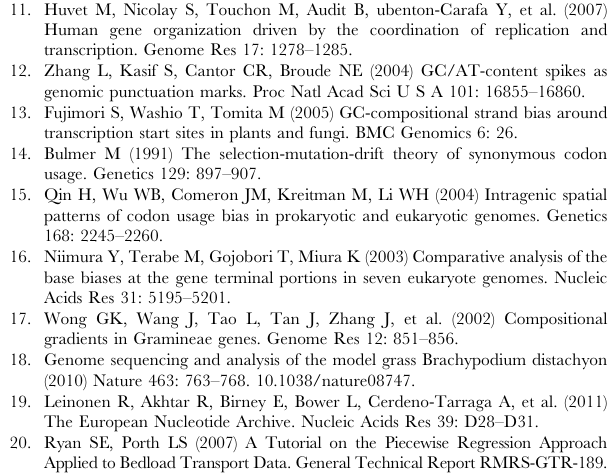
dataset with an adjacent window of 33 bp. The sequences were partitioned based on their length in seven dataset. Figure S19 Overall mononucleotide compositional trends of Physcomitrella coding sequences as a function of position and averaged over all sequences of each dataset with an adjacent window of 33 bp. The dataset ‘‘low’’ included sequence with a G + C content , = 0.40. The dataset medium included sequences with a G + C content . 0.40 and , = 0.50. Sequence with a G + C . 0.5 were included in the dataset ‘‘high’’. Figure S20 Overall mononucleotide compositional trends of Selaginella coding sequences as a function of position and averaged over all sequences of each dataset with an adjacent window of 33 bp. The dataset ‘‘low’’ included sequence with a G + C content , = 0.40. The dataset medium included sequences with a G + C content . 0.40 and , =0.50. Sequence with a G + C . 0.5 were included in the dataset ‘‘high’’. Figure S21 Overall first, second and third codon nucleotide content as function of position in Physcomitrella . Figure S22 Overall first, second and third codon nucleotide content as function of position in Selaginella. Figure S23 Dinucleotide content of the first 2 kb of Physcomitrella cds. The dinucleotide were calculated taking into account the first and second position of each codon. Figure S24 Dinucleotide content of the first 2 kb of Physcomitrella cds. The dinucleotide content were calculated taking into account the second and third position of each codon. Figure S25 Dinucleotide content of the first 2 kb of Physcomitrella cds. The dinucleotide content were calculated taking into account the third position of a codon and the first of the subsequent codon. Figure S26 Linear fitting of the trinucleotide biases of Oryza , Arabidopsis , Physcomytrella and Selaginella.